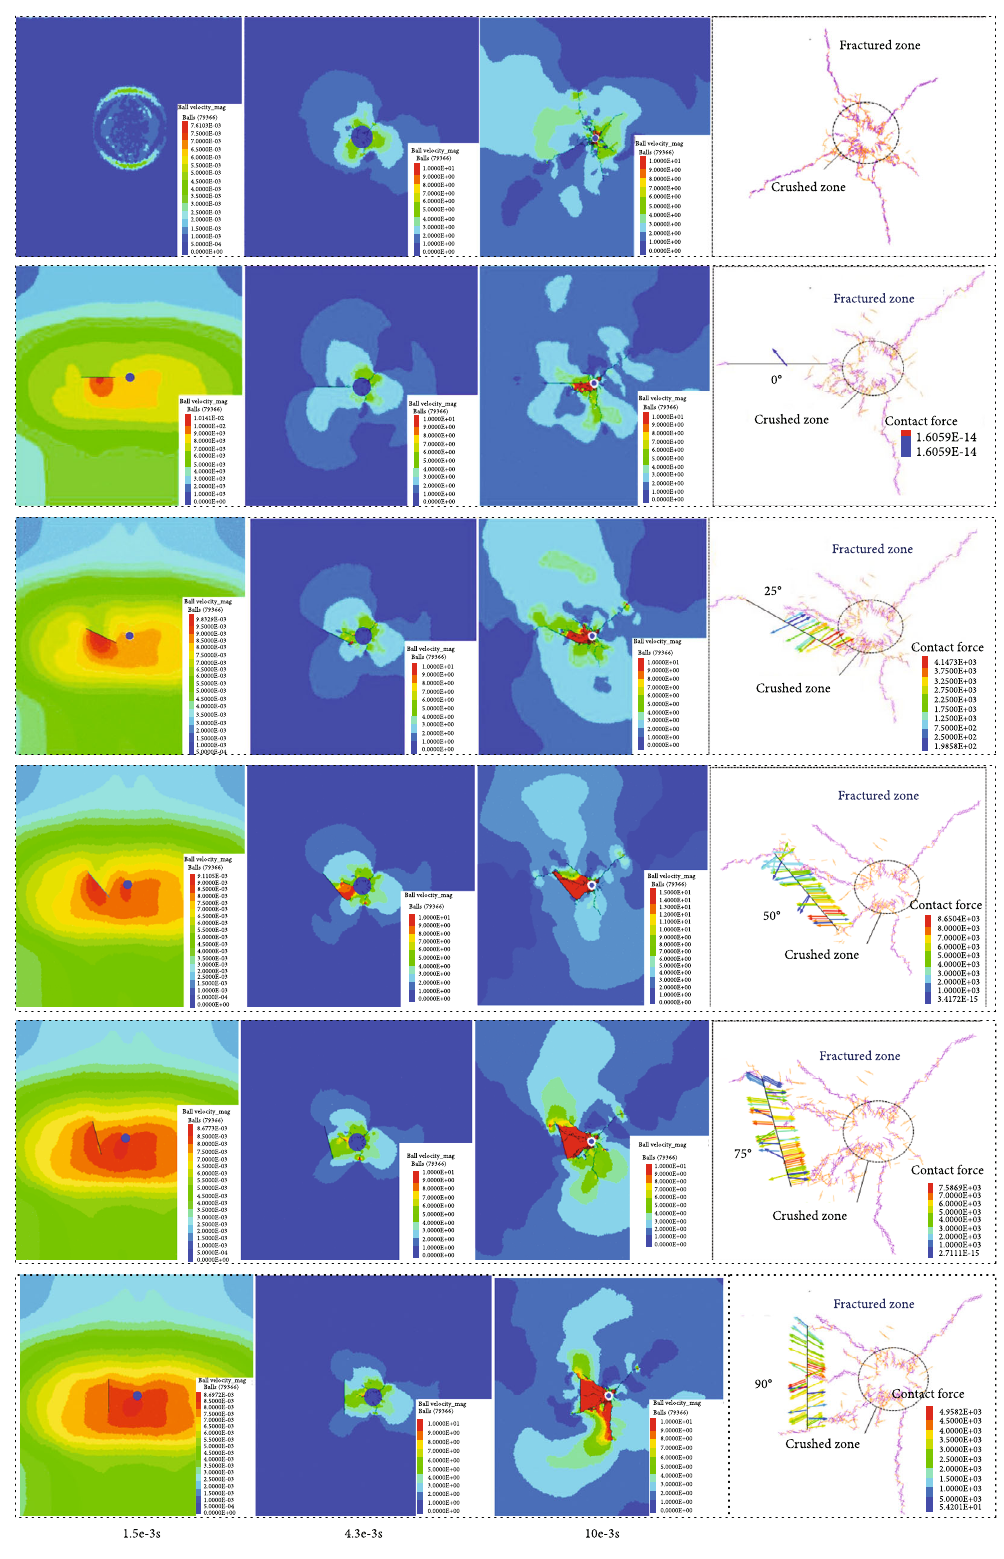
Figure 6: Evolution characteristics of explosion crack morphology in a single-jointed rock